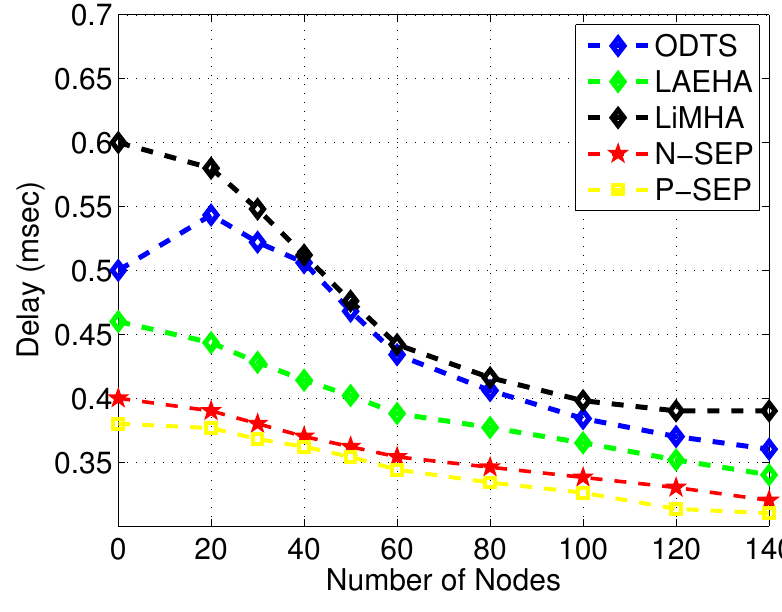
Figure 7. End 2 End